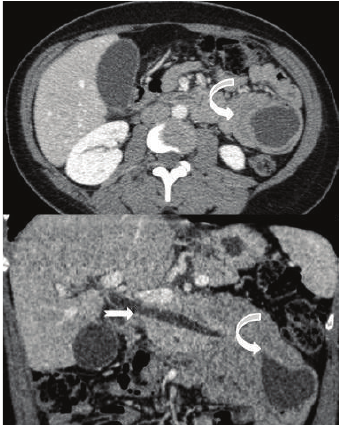
Figure 2: Axial and coronal CT shows that the distal duodenum with surrounding fat, vessels, and the pancreatic head were invagi- nated into the proximal jejunum (curve arrow). The common bile duct is dilated (single arrow).